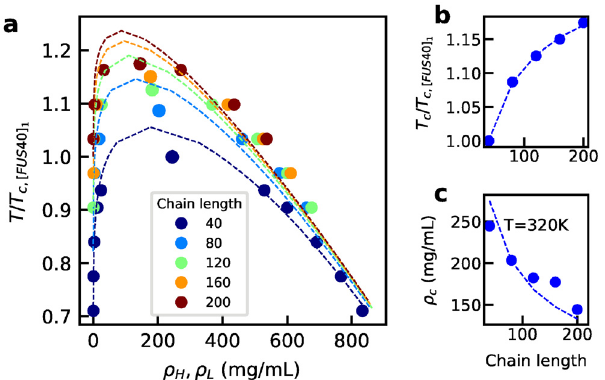
Fig 8. Phase separation of truncated FUS fragments of different lengths. a) Phase diagram for each peptide. Dashed lines show the fitting to binodal of Flory-Huggins theory. b) The critical temperature. Dashed lines show the fitting ffiffiffiffi p using relation T / N = ð þ 1 Þ 2 with prefactor as the fitting parameter. c) The critical concentration. Dashed lines N ffiffiffiffi p c show the fitting using relation r / 1 = ð þ 1 Þ with prefactor as the fitting parameter. Temperatures are scaled by N c the critical temperature of [FUS40] 1 . The corresponding slab density profiles are provided in S18